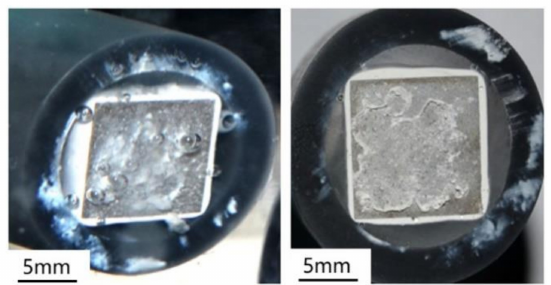
Figure 12. The in-situ macro surface morphologies of Al–BN ACS with 72 h immersion in 5.0 wt % NaCl solution and the as-corroded sample after